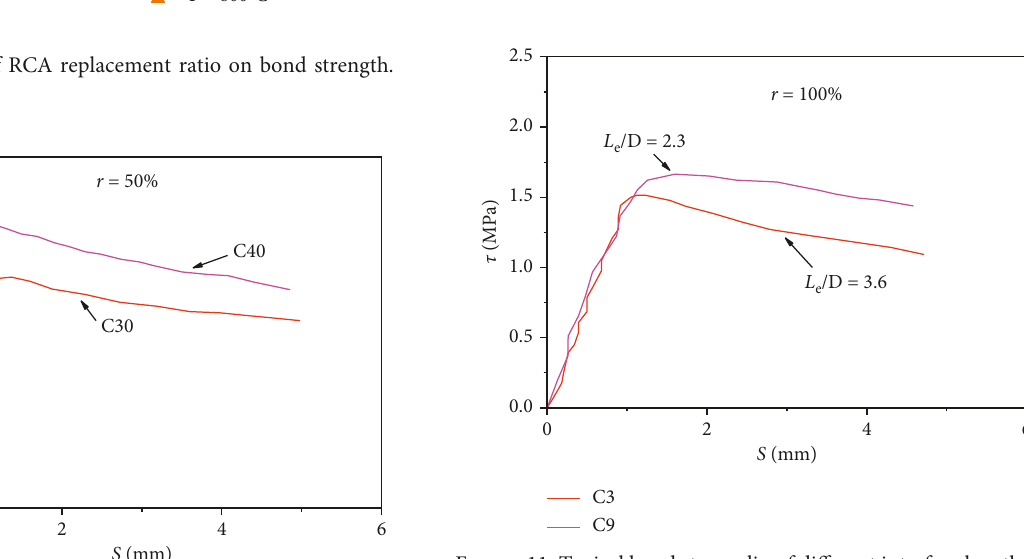
Figure 11: Typical bond stress-slip of different interface length-to- diameter